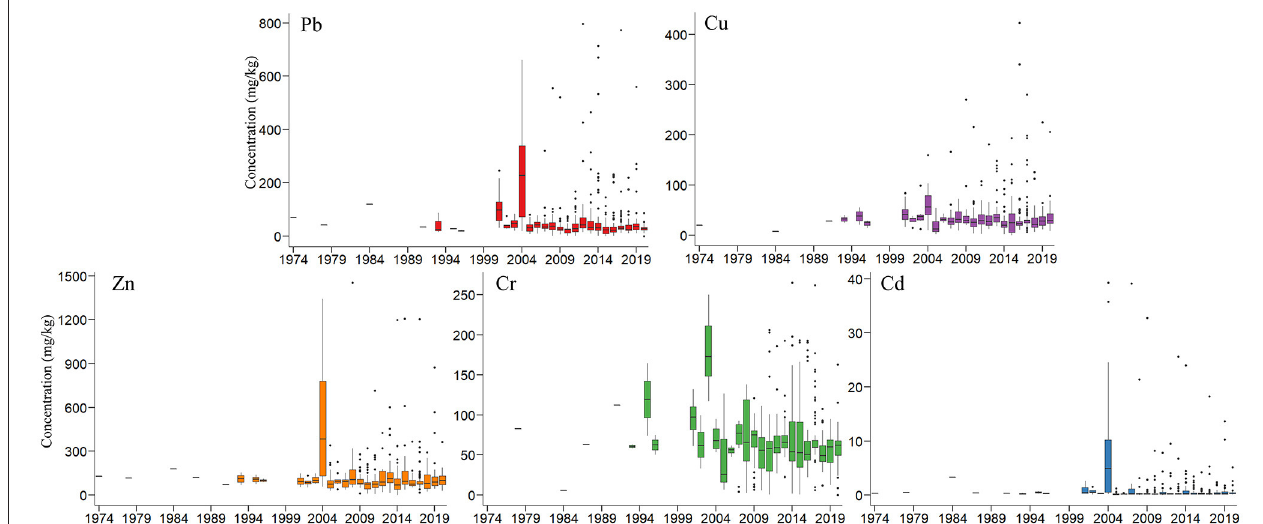
FIGURE 3 | The average heavy metal concentrations in agricultural soil in China (1974–2020). Data source: Data for 1974–2000 are compiled from Zhang et al. (22), Lin (23), Ding et al. (24), Wang (25), Feng et al. (26), Hu et al. (27), Ma and Xu (28), Yan (29), Zhou et al. (30), Liao (31), Wang et al. (32), Wen and Wei (33), and Zhang et al. ( 34). Data for 2000–2018 are from Zeng et al. (14). Data for 2019–2020 are compiled from Ali et al. (35), Chai et al. (36), Chen et al. (37), Guan et al. (38), Guo et al. ( 39), Han et al. (40), Hou et al. (41), Hu et al. (42), Huang et al. (43), Jiang and Guo (44), Jin et al. (45), Jin et al. (46), Lu et al. (47), Lv and Sun (48), Song et al. (49), Wang et al. (50), Wu et al. (51), Xiao et al. (52), Yang et al. (53), Zhao et al. (54), Zhou et al. (55), Bao et al. (56), Cao et al. (57), Chai et al. (58), Cheng (59), Duan et al. ( 60), Guo et al. (61), He et al. (62), Hu et al. (63), Ji et al. (64), Kuerban et al. (65), Li et al. (66), Ma et al. (67), Miao et al. (68), Peng et al. (69), Shi et al. (70), Su and